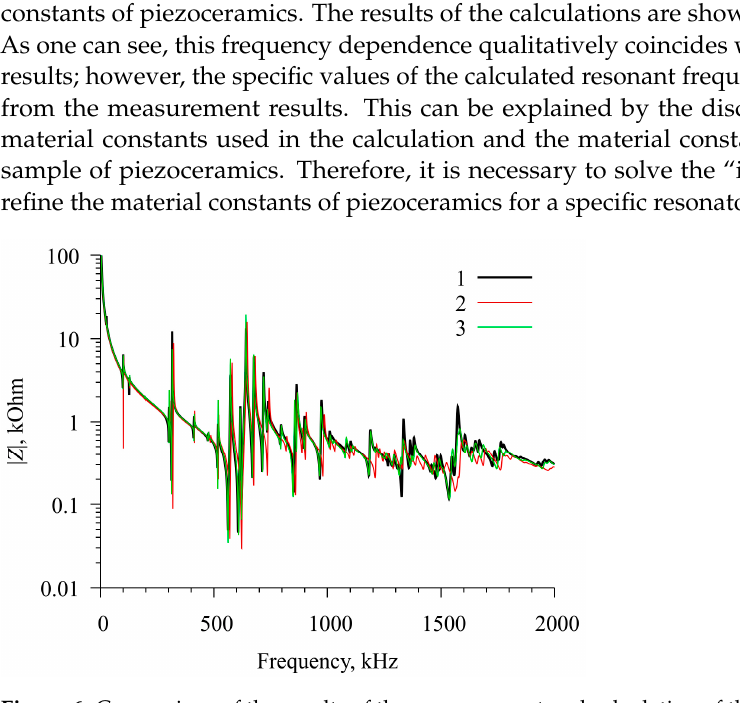
Figure 6. Comparison of the results of the measurement and calculation of the frequency dependence of the electrical impedance for a free radial electric field excited resonator at a temperature of 35 °C. Curve 1 is the measurement result, curve 2 is the result of calculation using the original material constants, and curve 3 is the result of calculation using the refined values of the material constants.